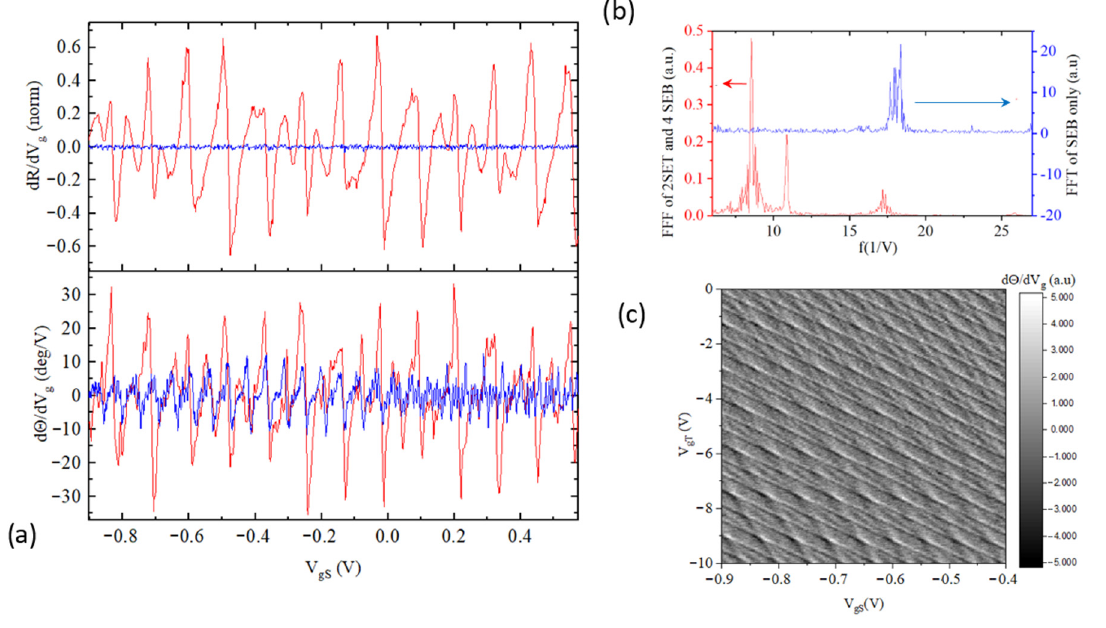
Figure 19. ( a ) Comparison of performance between combined structure (2 DCD SETs + 4 SEB) devices (red) and 4 SEB devices only (blue); ( b ) FFT for the respective cases: 2 DCD SETs + 4 SEB) devices (red) and 4 SEB devices only (blue) and ( c ) 2D map of d Θ / dV g oscillations reveals distinct pattern composed of four crossing lines, characteristic of SEB. T = 0.305 K.